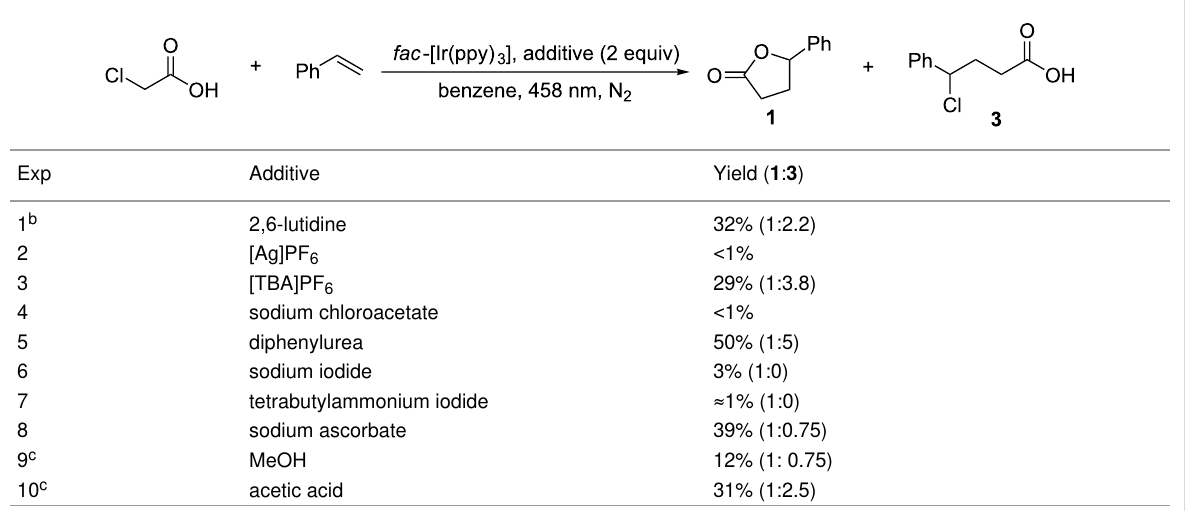
Exp Additive Yield ( 1 : 3